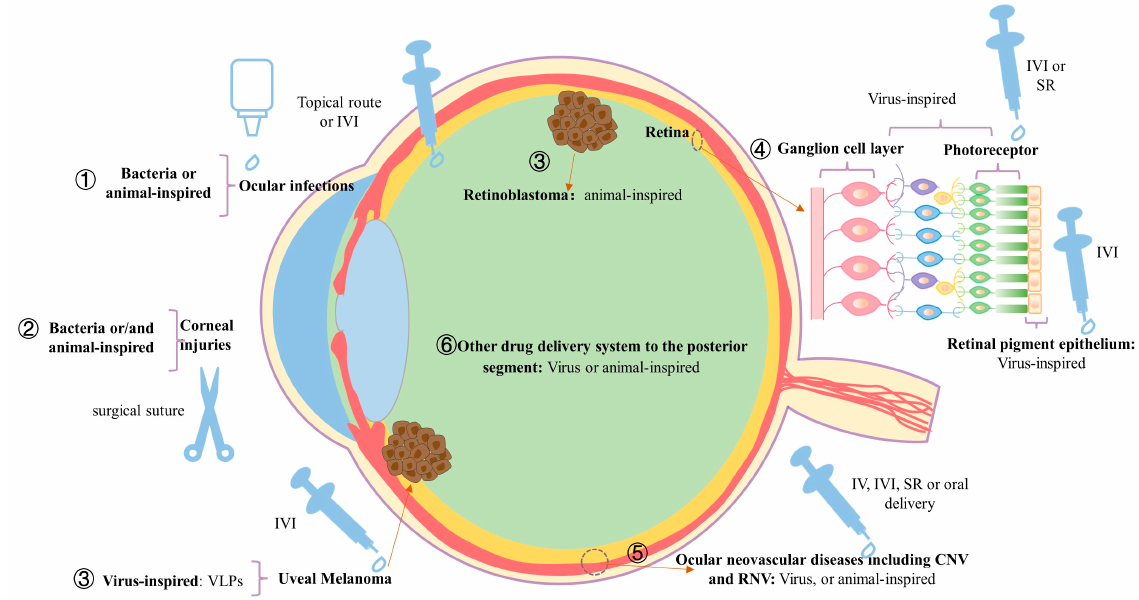
Figure 2. Applications of the bioinspired nanocarrier for ocular disorders: (1) Ocular infections: the inspirations include the acid environment produced by the bacteria, the temperature of humans, and the receptors expressed on the surface of the corneal epithelial cells. (2) Regenerative ophthal ‐ mology: the inspirations include stem cell ‐ derived EVs, BNC, and BNC ‐ loaded human stem cell ‐ derived cells. (3) Eye tumors: the inspirations include the VLPs and the receptors expressed on the surface of tumor cells. (4) Retina ‐ targeting gene therapy: the inspirations include the virus itself. (5) Ocular neovascular disease: the inspirations include the virus, cell membrane, and EVs. (6) Other drug delivery systems to the posterior eye: the inspirations include the VLPs, the special environ ‐ ment of the ocular disorders, and the receptors expressed on the surface of corneal epithelial. Ab ‐ breviations: IVI, intravitreal injection; VLP, virus ‐ like particle ； SR, subretinal; IV, intravenous; CNV, choroidal neovascularization; RNV, retinal neovascularization; EVs, extracellular vesicles; BNC, bacterial nanocellulose. 3.1. Bioinspired Nanostructured Systems for the Treatment of Anterior Segment Ocular Disorders The applications of bioinspired nanocarriers for anterior segment ocular disorders include, but are not limited to, the following ocular infections and regenerative ophthal ‐ mology. As shown in Table 2, owing to space limitations, we will take some representative investigations as examples. Table 2. The application of bacteria in different nano ‐ drug delivery systems. Disease